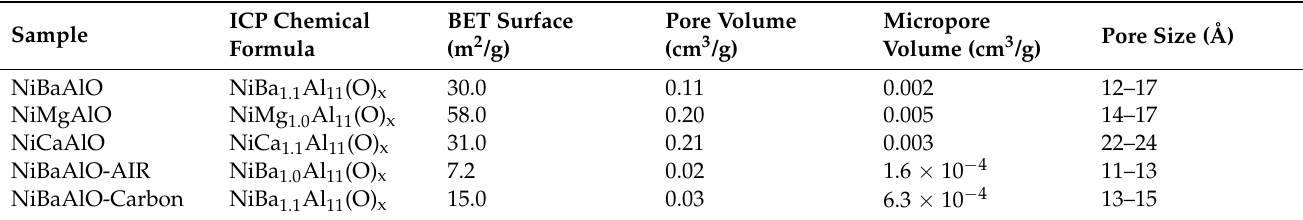
Table 1. Textural and chemical data of NiBaAlO, NiMgAlO, and NiCaAlO